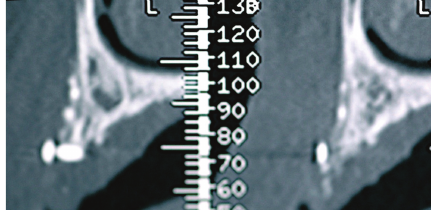
Figure 3: Cross-sectional CBCT scan showing the residual graft material and the cortical screw more coronally.